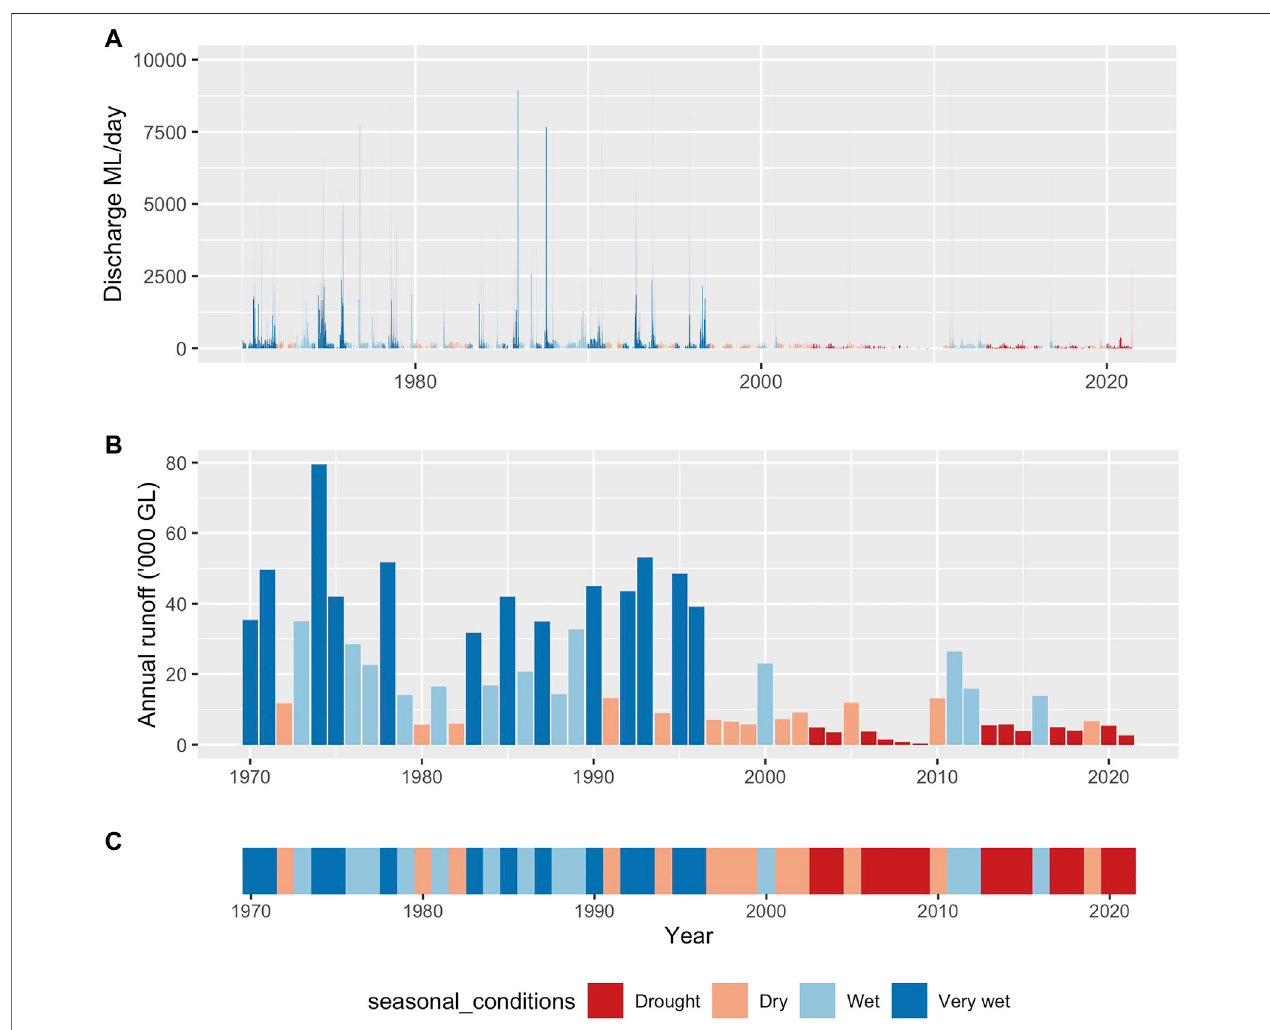
FIGURE 2 | (A) daily runoff time series (Megalitres), (B) annual runoff estimates (Gigalitres), and (C) annual fl ow class sequence (Drought, Dry, Wet and Very Wet), with classes derived from quartiles of annual runoff ordered from driest to wettest.